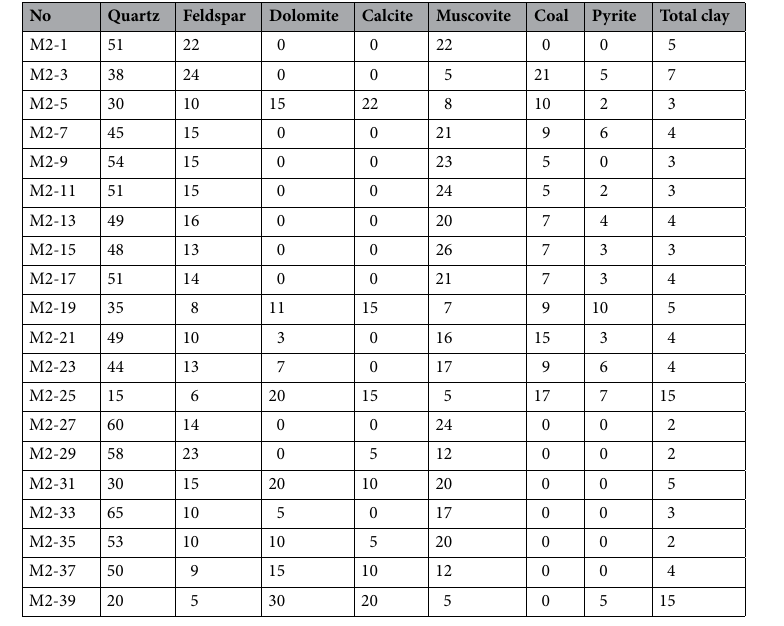
Table 1. XRD results of the Late Cretaceous samples from M2, Jitai Basin (unit in